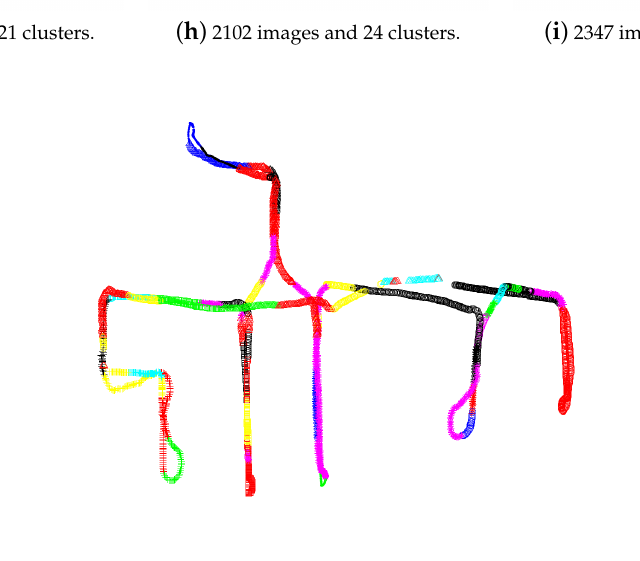
Figure 15. Maps obtained during the process using HOG y = 0.75, Ω = 1.7 with the Freiburg route. The subfigures show different steps of the process. In the end, the process detects 30 nodes and the final average silhouette is − 0.1526. The pair of e , f shows how the node merging process